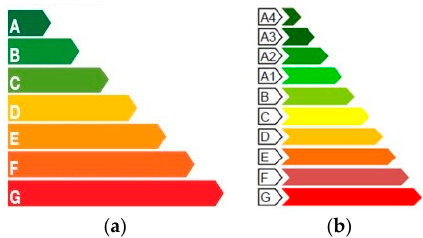
Figure 2. Performance classes in accordance to: Presidential Decree 59/2009 [45] ( a ); Ministerial Decree 26 June 2015 [48] ( b ).